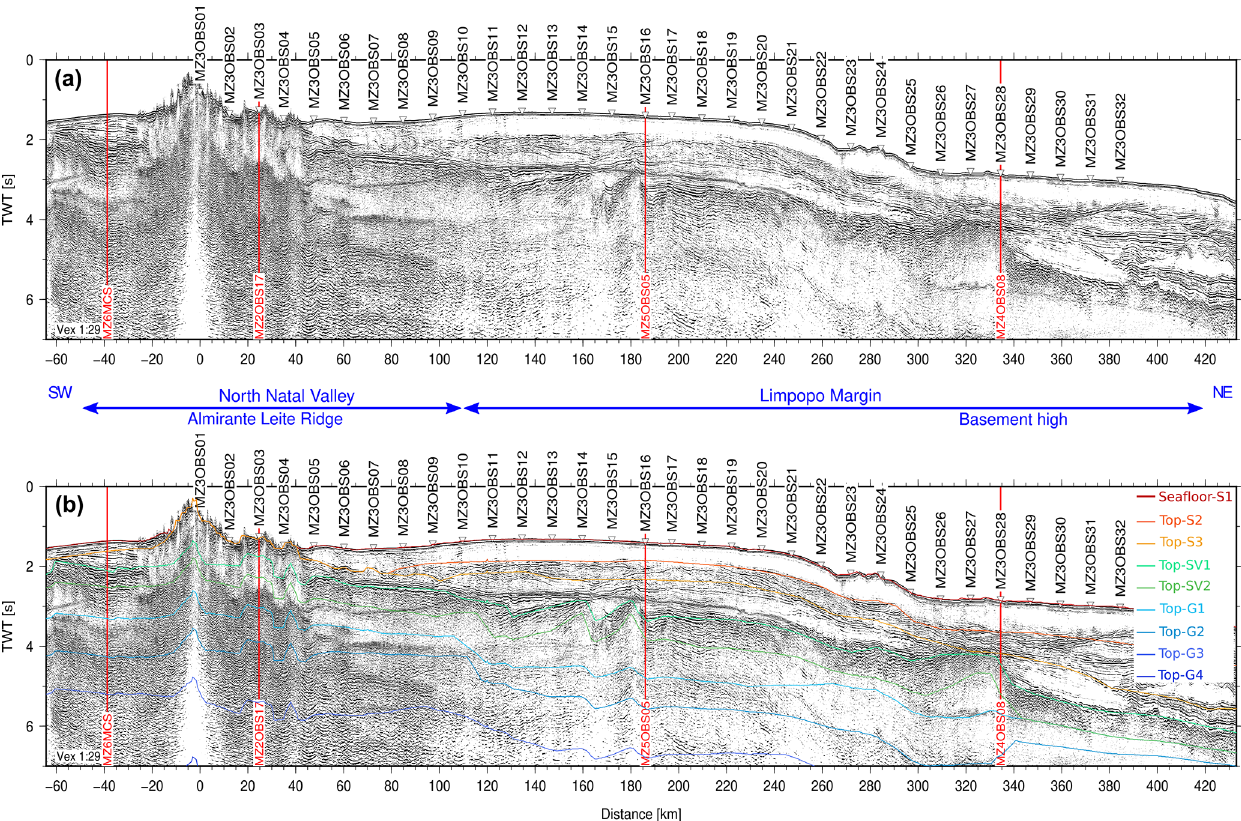
Figure 3. (a) Two-way travel time record section of MCS data along the MZ3 profile. (b) The same as (a) but overlain by time-converted interfaces from the coincident wide-angle velocity model. Intersections with other profiles from the MOZ35 cruise are indicated by a red line. OBS locations are indicated by inverted